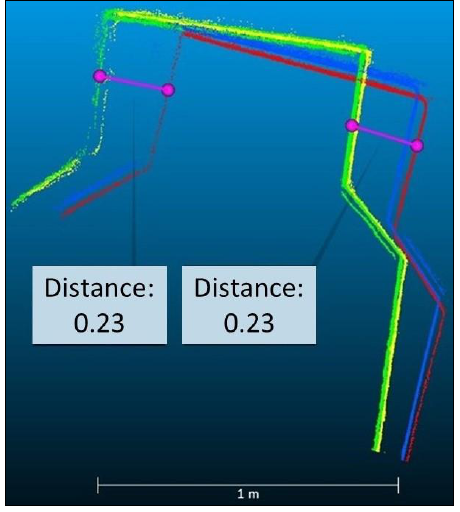
Figure 13 . Cross-section view of the displacements [m]